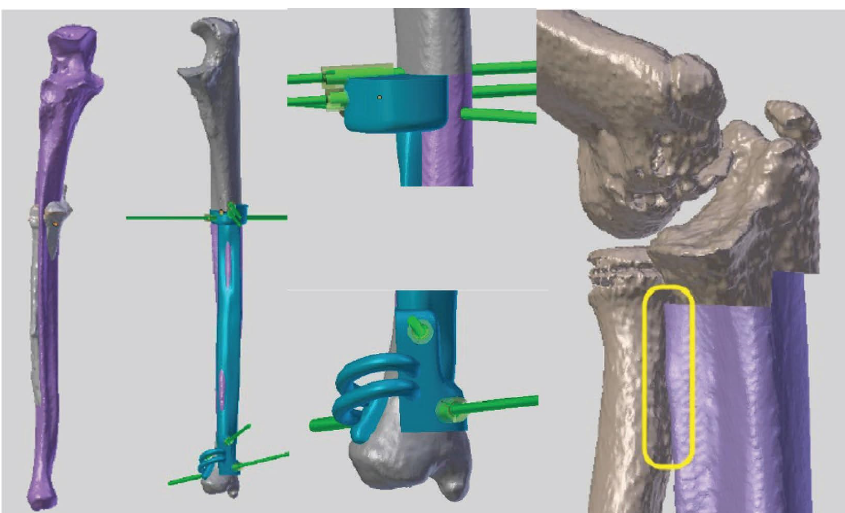
Figure 3: Te same patient mentioned in Figure 1. Te best matching allograft was obtained from an adult and was oversized. From left to right: (1) Ulna of the patient in grey and allograft in mauve. (2) PSI for allograft cutting. (3) Detail of the proximal part of the PSI and the distal part of the PSI. (4) Simulation of reconstruction with the allograft after tumor resection (patient in grey and allograft in mauve).